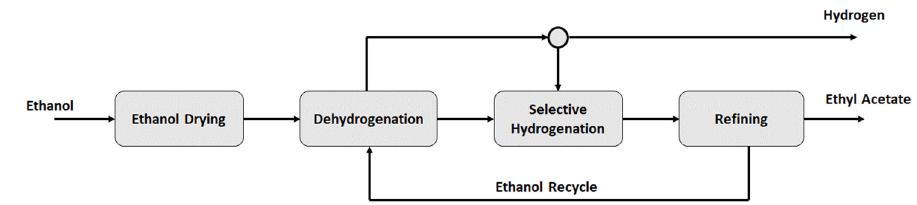
Figure 5. Simplified scheme of the DAVY process for ethanol dehydrogenation [43].